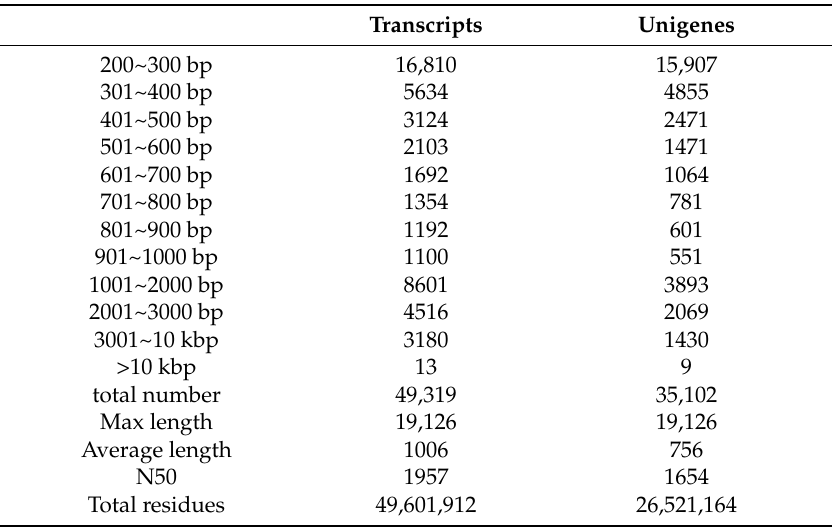
Table 2. Transcripts and Unigene length distribution